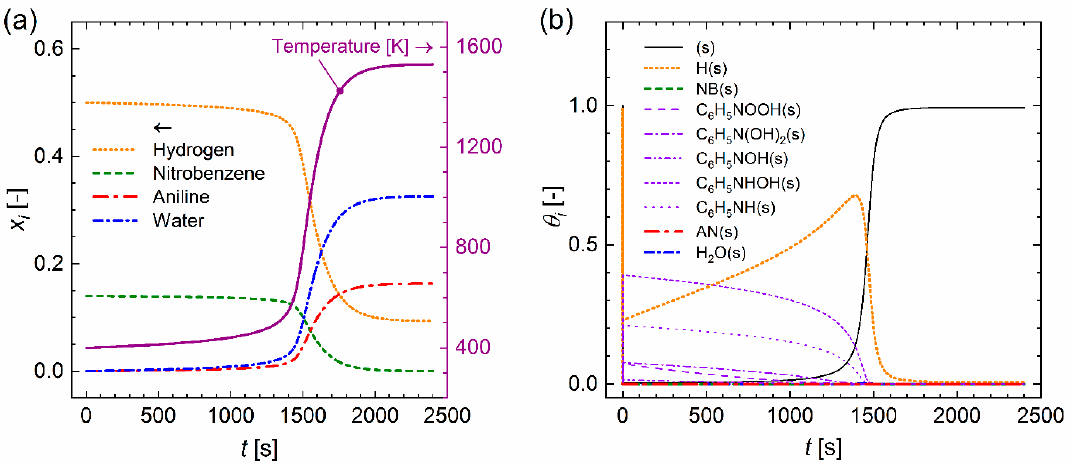
Figure 3. Results for CSTR test case. ( a ) Time evolutions of mole fractions of bulk species and temperature. ( b ) Site fractions of surface species.